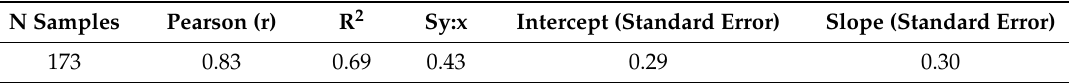
Table 1. Main parameters defining the regression line obtained plotting reference method and Micro Biological Survey (MBS) results.